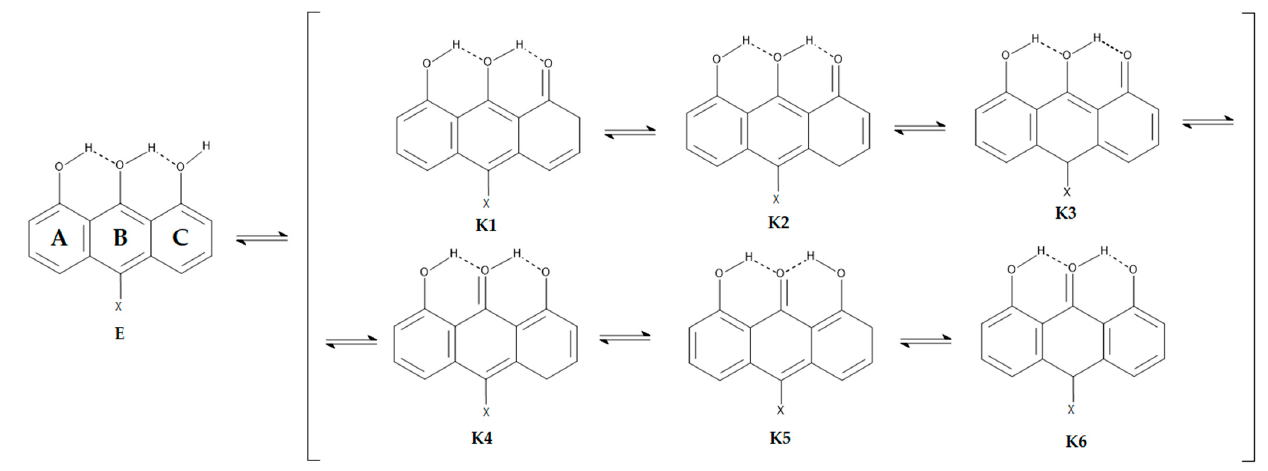
Scheme 3. Tautomeric equilibrium in Table 1. G at 298 K, α and HOMA parameter for optimized isomers .